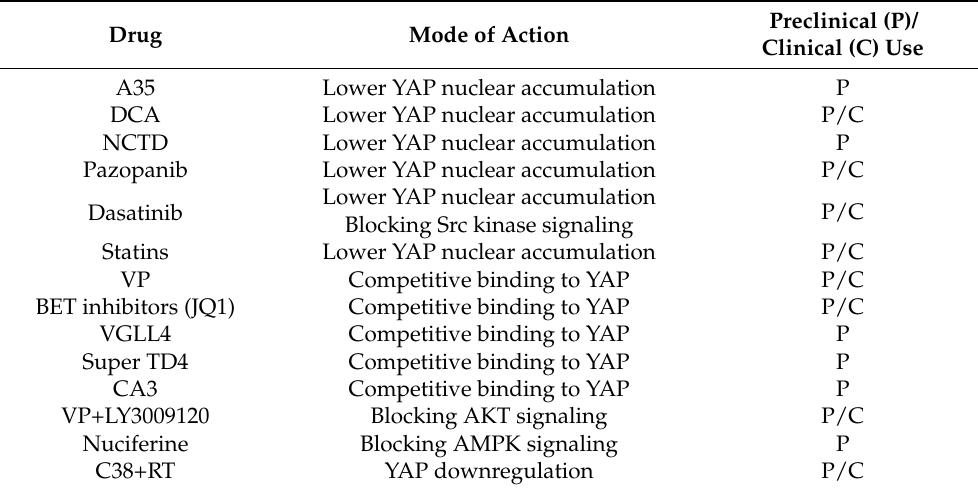
Table 1. Summary of the most known YAP inhibitors.